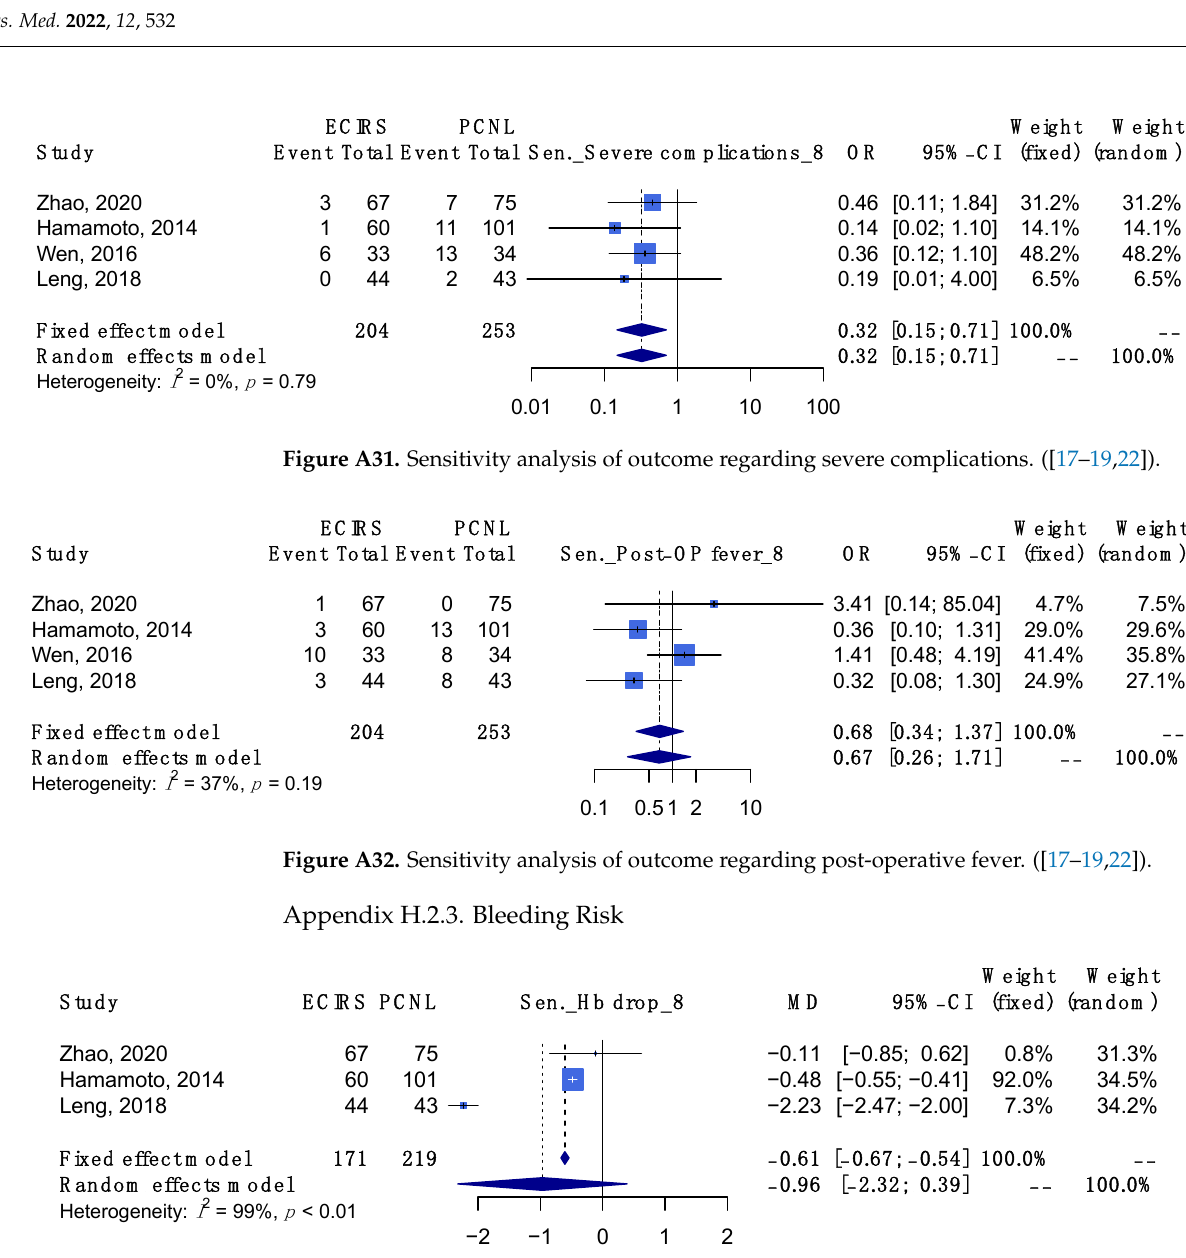
Study Fixed effect m odel R andom effects m odel Heterogeneity: I 2 = 0%, p = 0.68 Zhao, 2020 Hamamoto, 2014 Wen, 2016 Leng, 2018